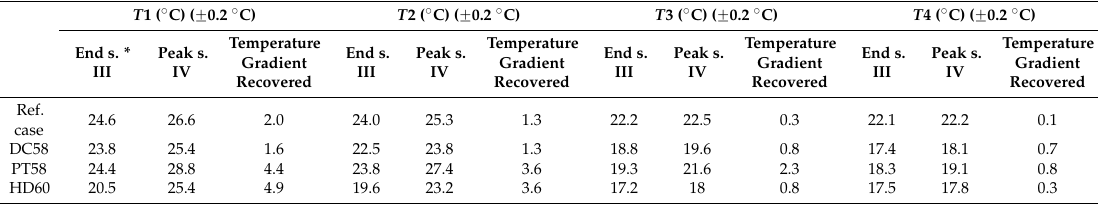
Table 7. Temperature gradients recovered after the large demand at each temperature sensor.